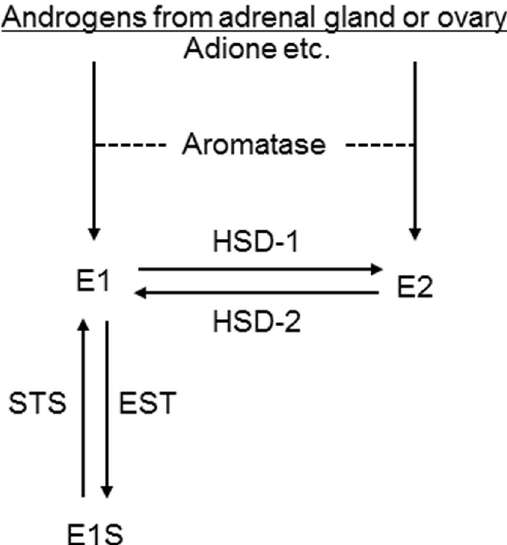
Figure 1. Estrogen-metabolizing enzymes. Aromatase, STS, and HSD-1 act in a direction producing more active estrogens, whereas EST and HSD-2 act in the opposite direction. Adione, androstenedione; E1, estrone; E1S, estrone sulfate; E2, estradiol; STS, steroid sulfatase; EST, estrone sulfotransferase; HSD-1, 17 β -hydroxysteroid dehydrogenase type 1; HSD-2, 17 β -hydroxysteroid dehydrogenase type